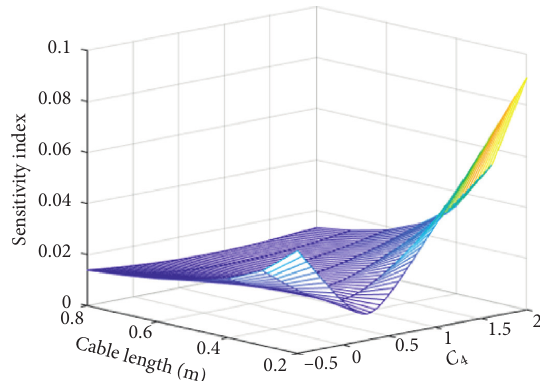
Figure 3: Sensitivity index over different cable lengths and input values ( C 4 ) with the standard maneuver time.